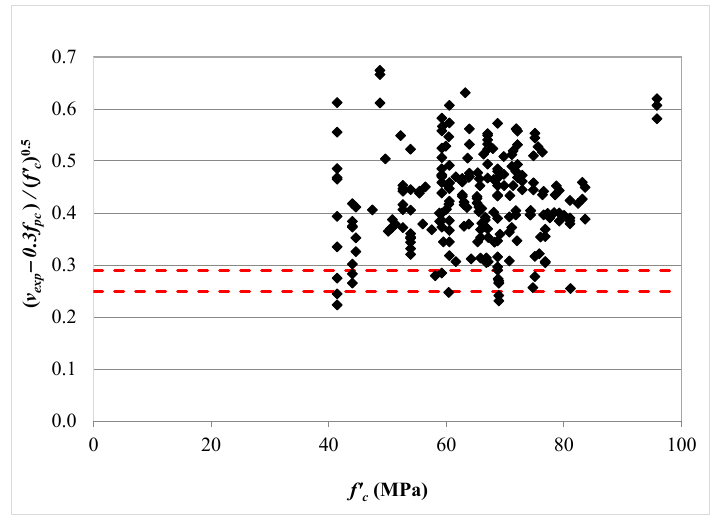
Figure 13. Concrete tensile strength at the occurrence of web shear cracking.